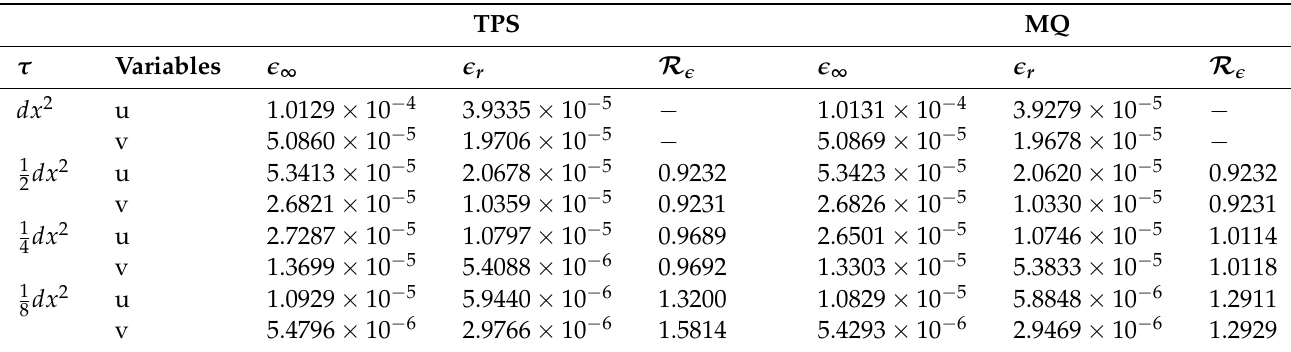
Table 2. Error estimates and CPU times of Example 1 by letting dx = 1 values of τ